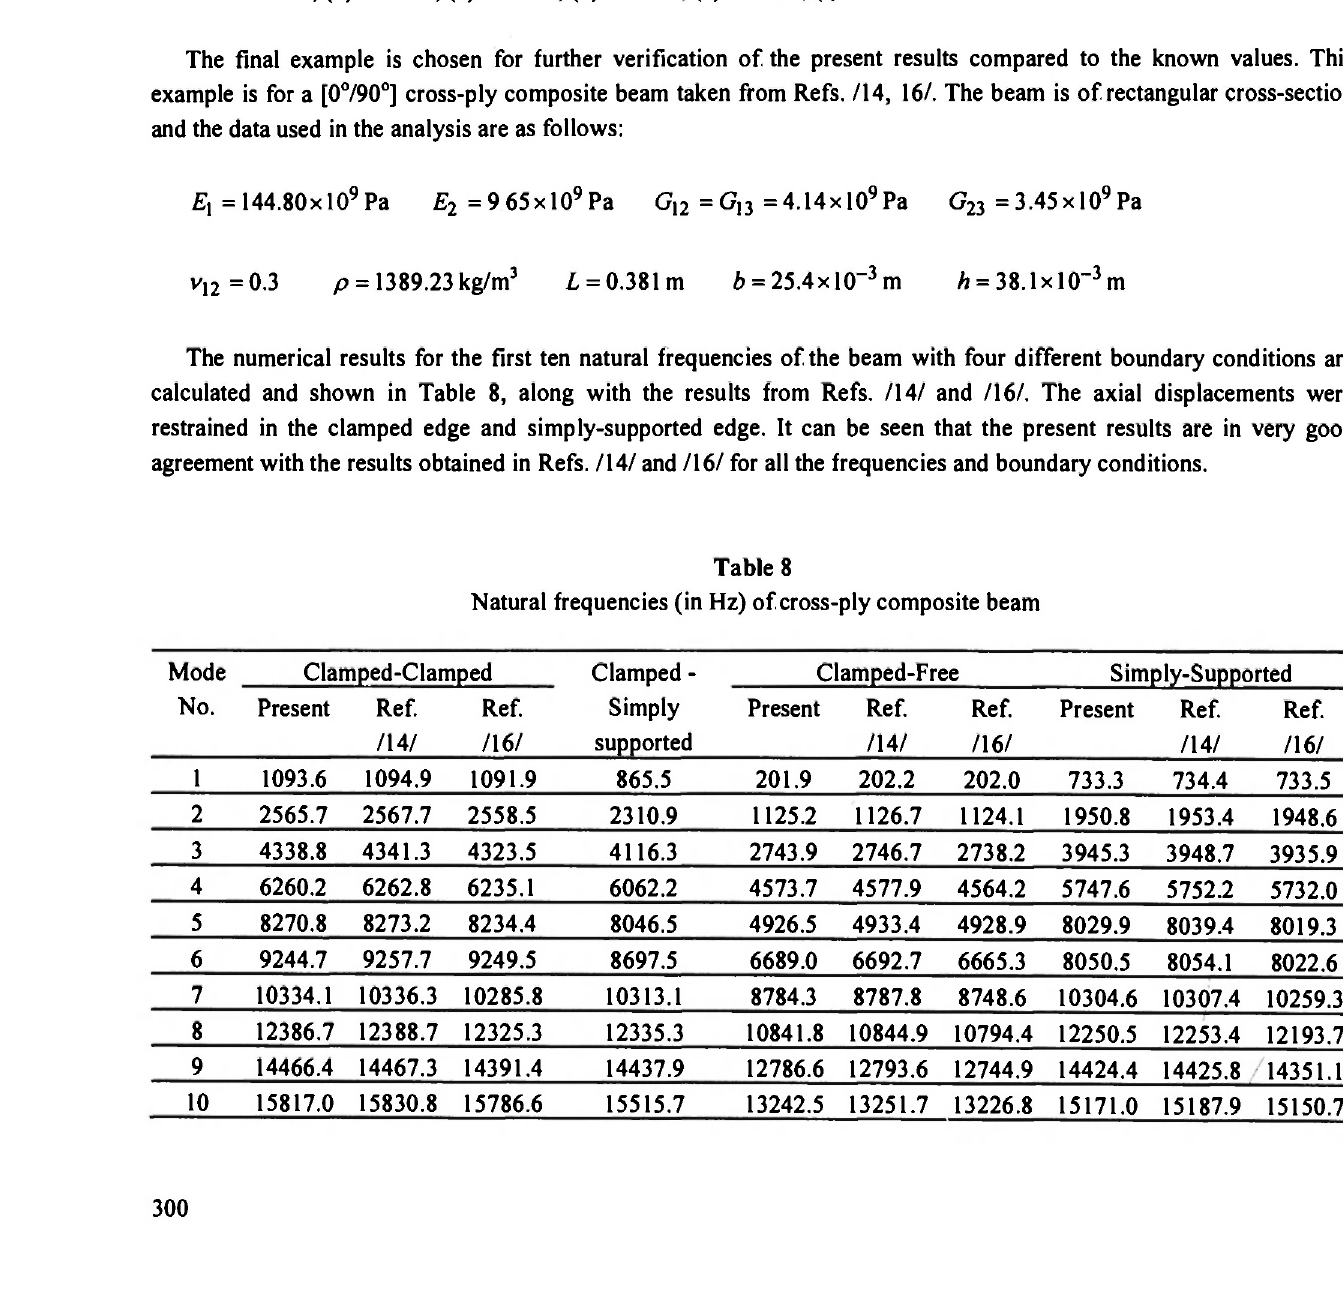
Fig. 6: First six normal mode shapes of Clamped-Free composite beam with E x = 221 χ 10 9 Pa and L = 0.572 m (a) mode 1; (b) mode 2; (c) mode 3; (d) mode 4; (e) mode 5; (f) mode